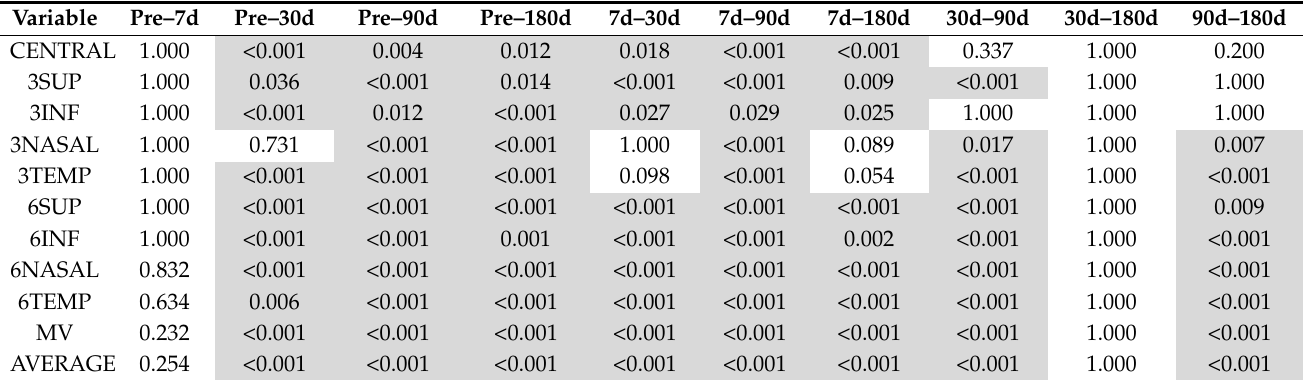
Table 1. p -values paired test of comparison between different time points for all variables. Differences with p -values < 0.05 are shown in shade.